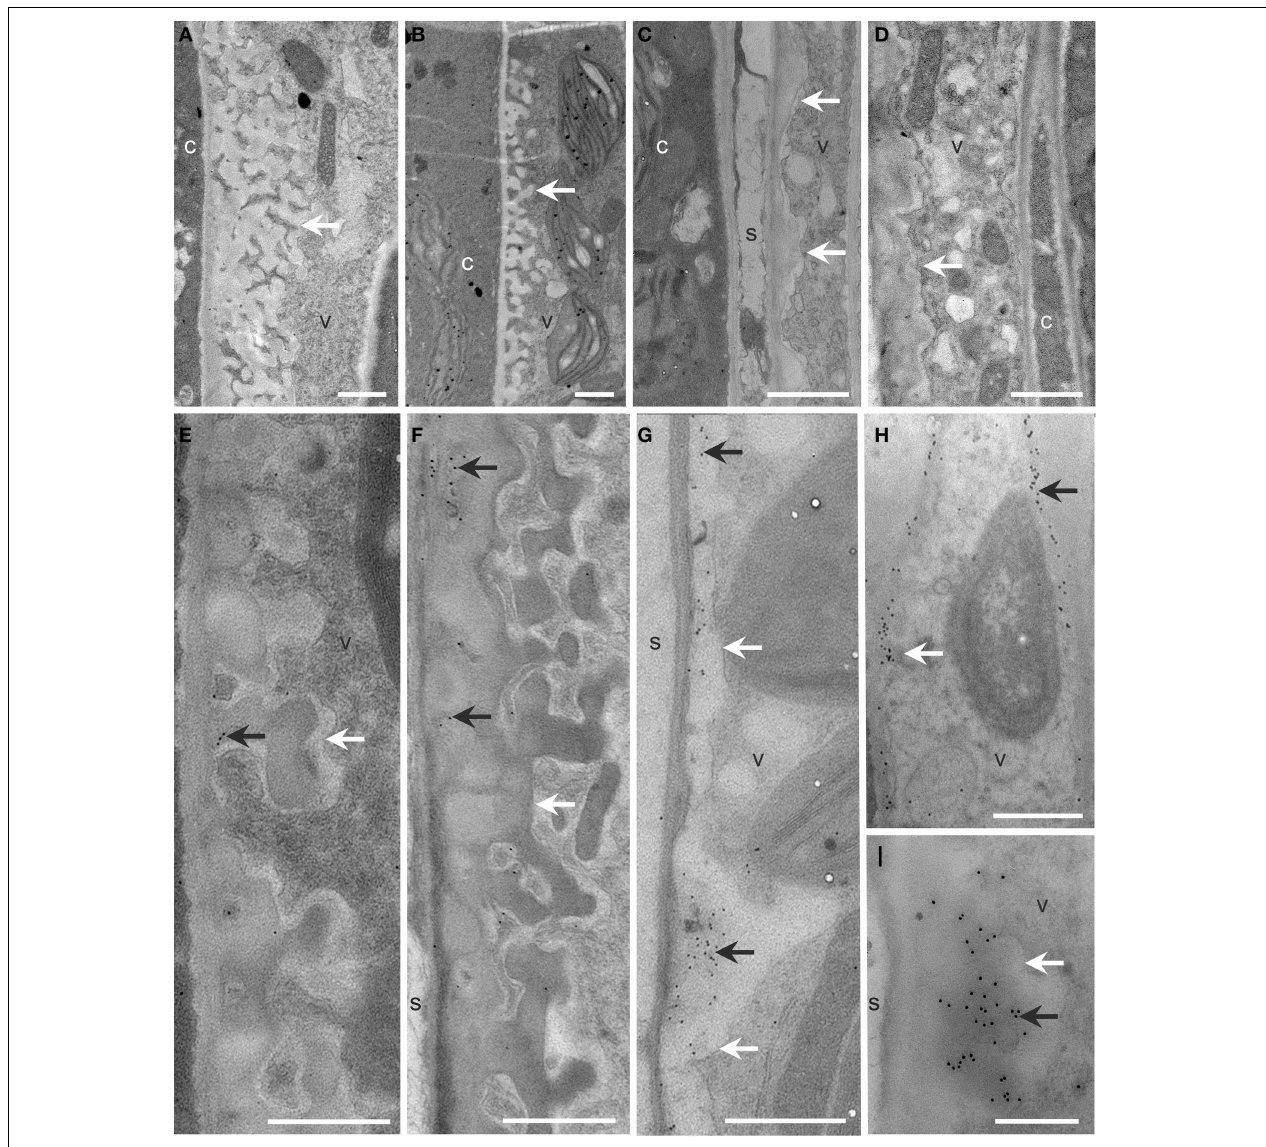
FIGURE 6 | Cellular structure and immunodetection of callose after 3 days of LT treatment. Col, gsl5 , vte2 , and gsl5 vte2 were grown under permissive conditions for 4 weeks and transferred to LT conditions for 3 additional days. Col (A,E) , gsl5 (B,F) , vte2 (C,G) , and gsl5 vte2 (D,H,I) . Black